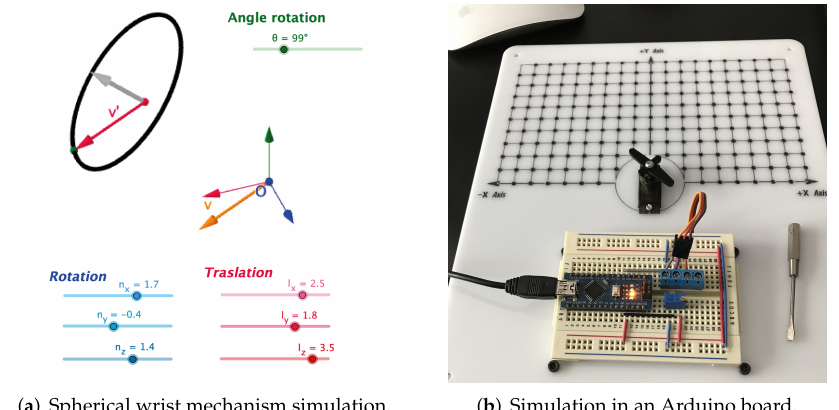
Figure 9. Simulation for the spherical wrist mechanism.